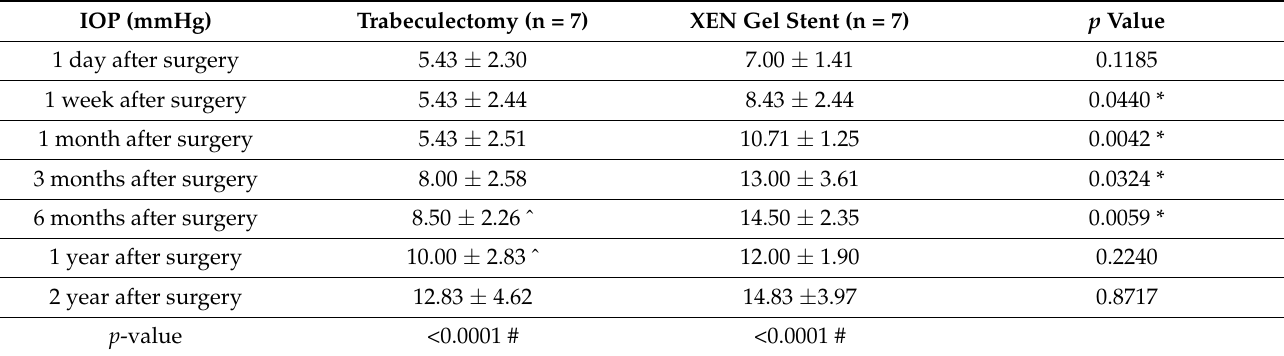
Table 2. Postoperative IOP